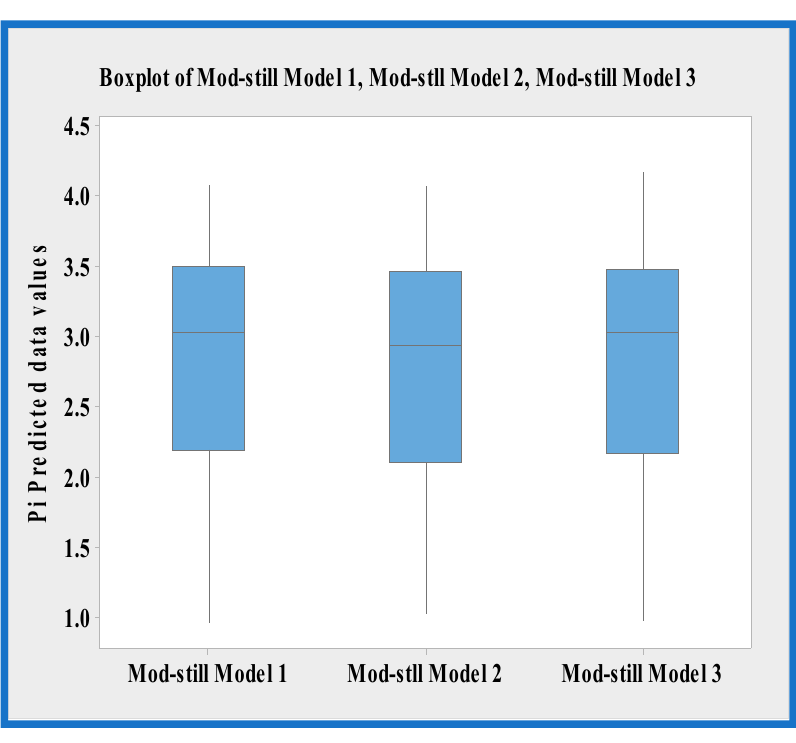
Figure 6. Boxplot comparing productivities by Models 1, 2, and 3 (mod-still).